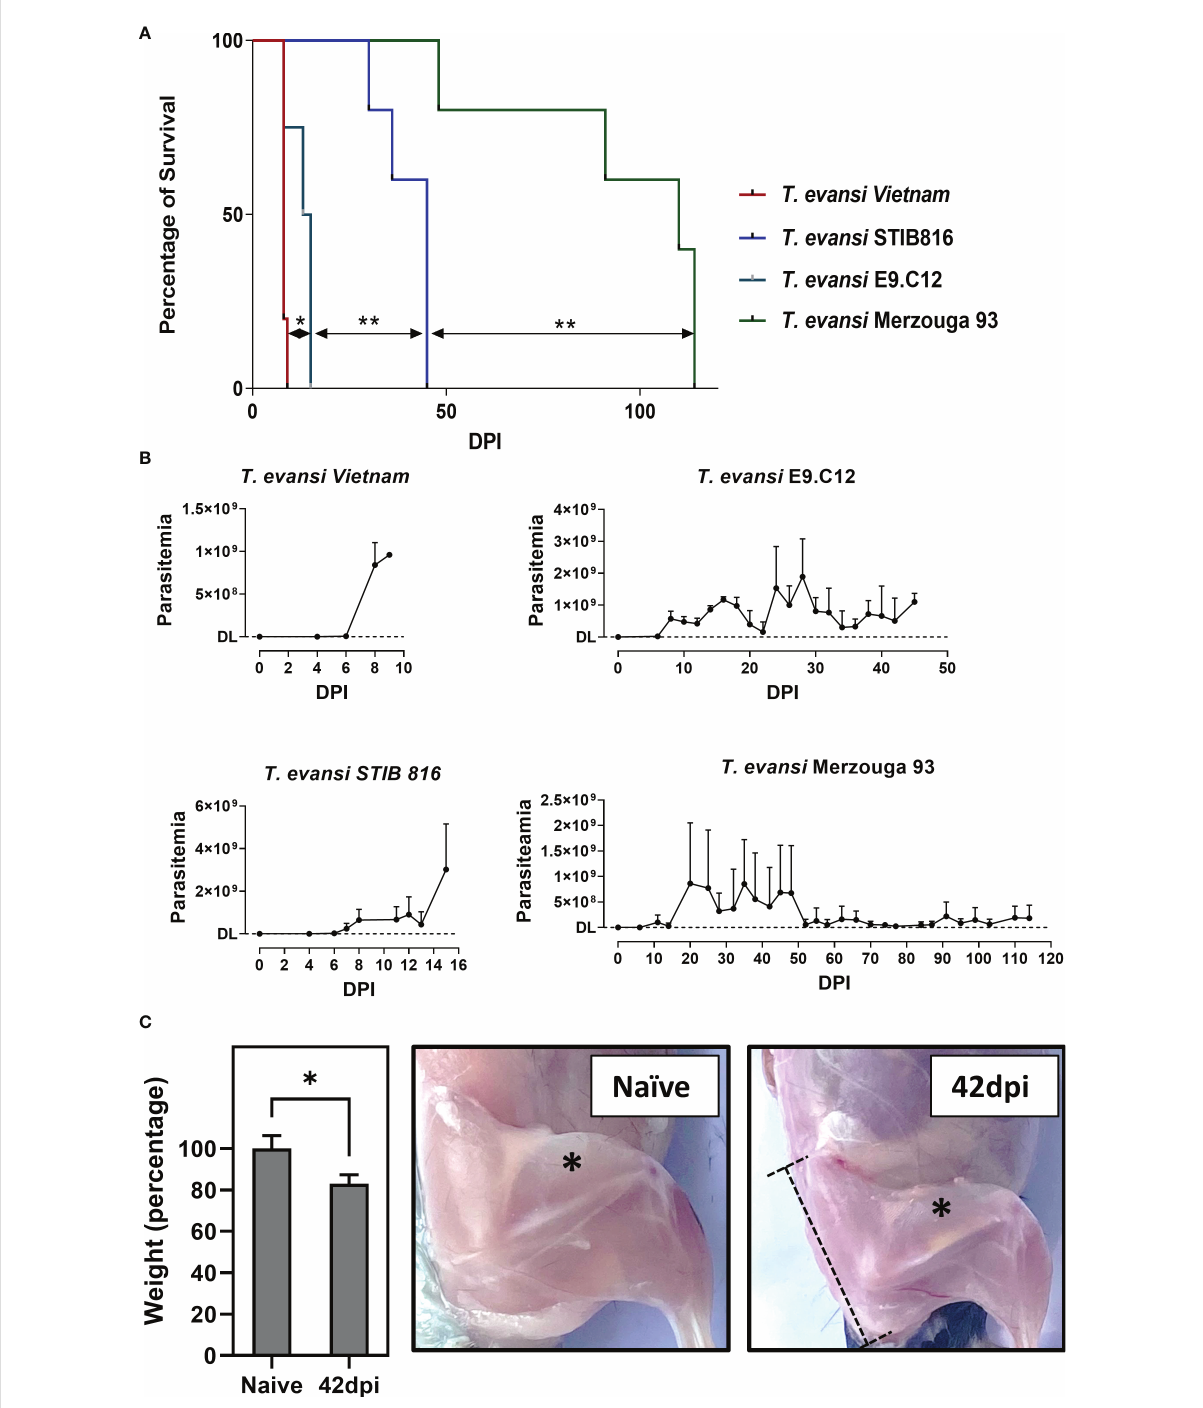
FIGURE 1 Chronic infection by T. evansi Merzouga 93 is similar to infections in domestic animals. (A) Survival curve of 4 representative isolates: T. evansi Vietnam (hyper-virulent), T. evansi STIB816 (virulent), T. evansi E9.C12 (intermediate), and T. evansi Merzouga 93 (chronic). *p ≤ 0.05, **p ≤ 0.01 by Log-rank test. (B) Parasitemia pro fi les of 4 isolates during infection. Data are presented as mean + SD from 5 individual mice per group. The Y axis indicates the number of parasites, DL: detection limit (4x10 5 parasites/ml blood). (C) Left panel: Weight reduction in percentage of infected mice (42dpi) relative to naïve mice. Data is presented as mean + SD of mice ’ s body weight after subtracting the weight of spleen and liver. *p ≤ 0.05 by Student t-test vs naïve values. Right panels: Catabolic muscle breakdown observed during chronic infection of T. evansi Merzouga 93. The asterisk indicates the location of quadriceps muscle, the dashed bar indicates the location of the Pelvis